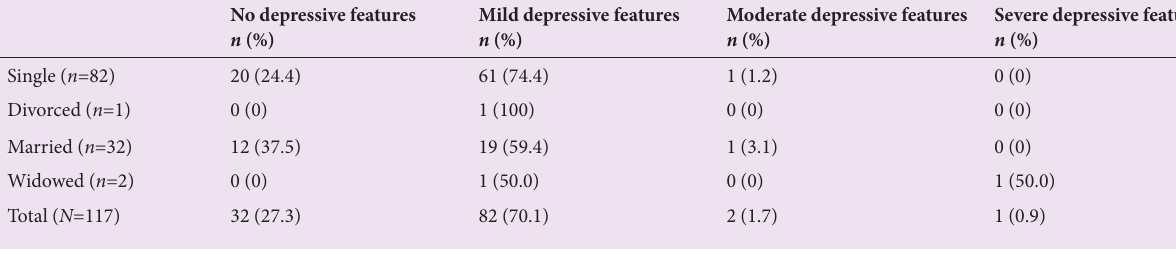
Table 4. Comparison of marital status and severity of depressive features